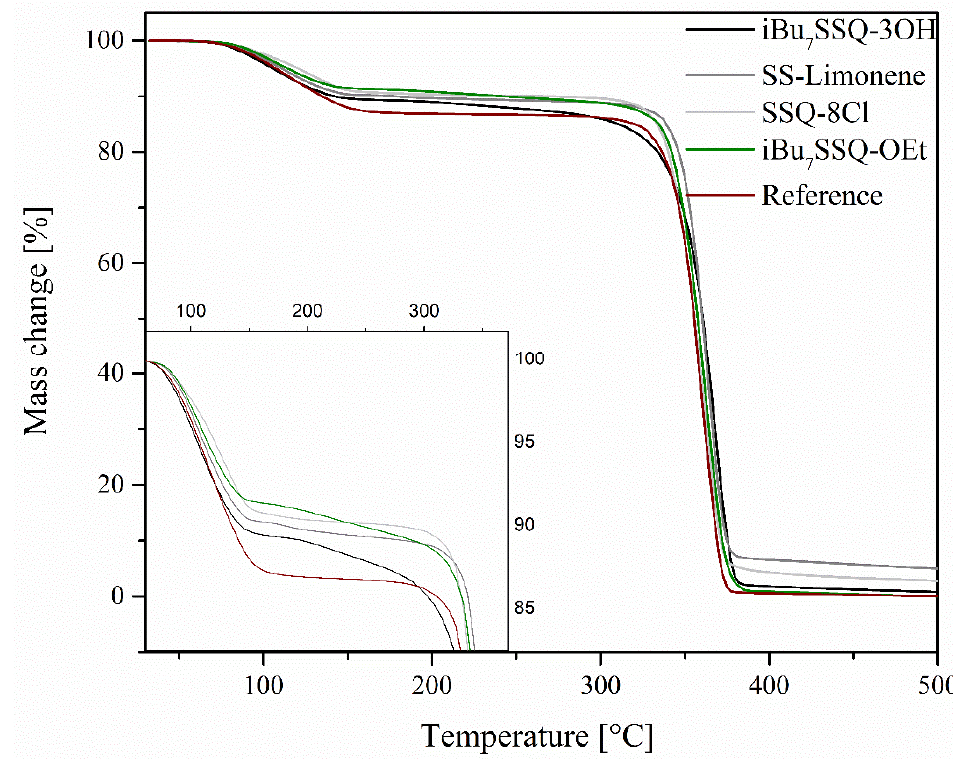
Figure 3. TGA curves of the obtained electrospun materials.